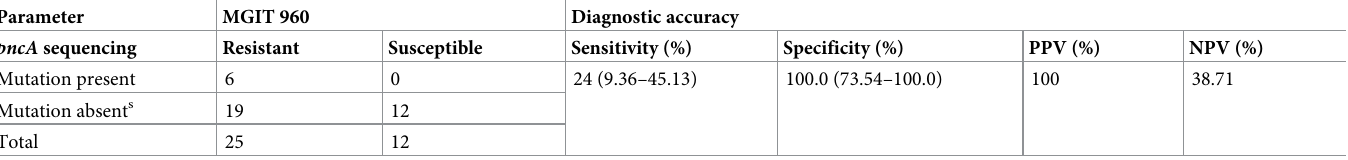
Table 2. Showing diagnostic performance of PZA sequencing for PZA resistance